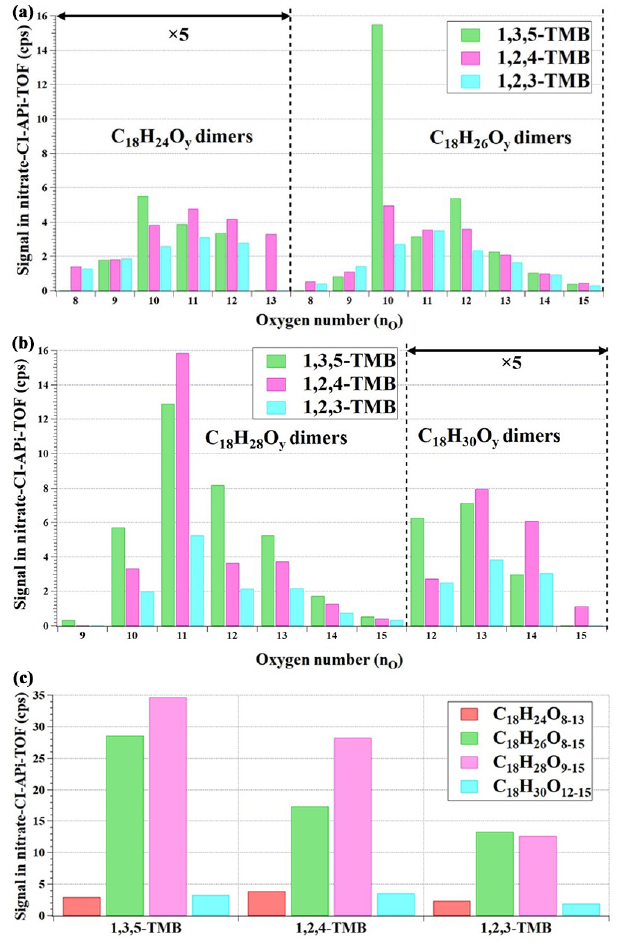
Figure 4. (a) Distribution of C 18 H 24 O 8 − 13 and C 18 H 26 O 8 − 15 products formed from TMB oxidation experiments (Exp. 1–3 in